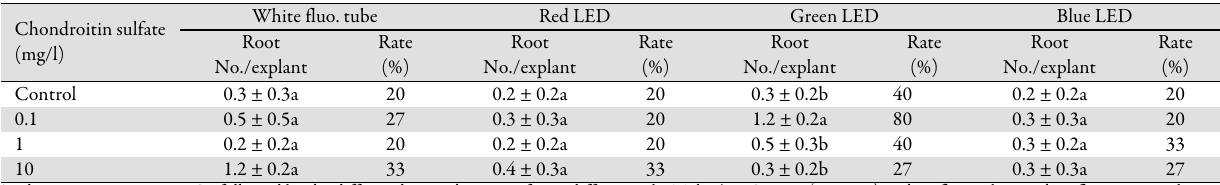
chondroitin sulfate under different sources of lights.